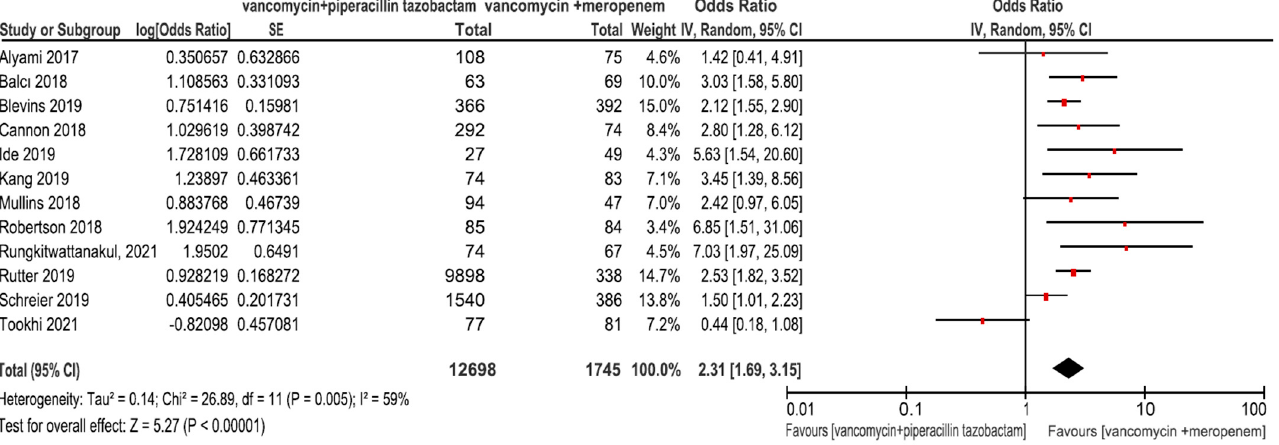
Figure 2. Acute kidney injury (AKI).